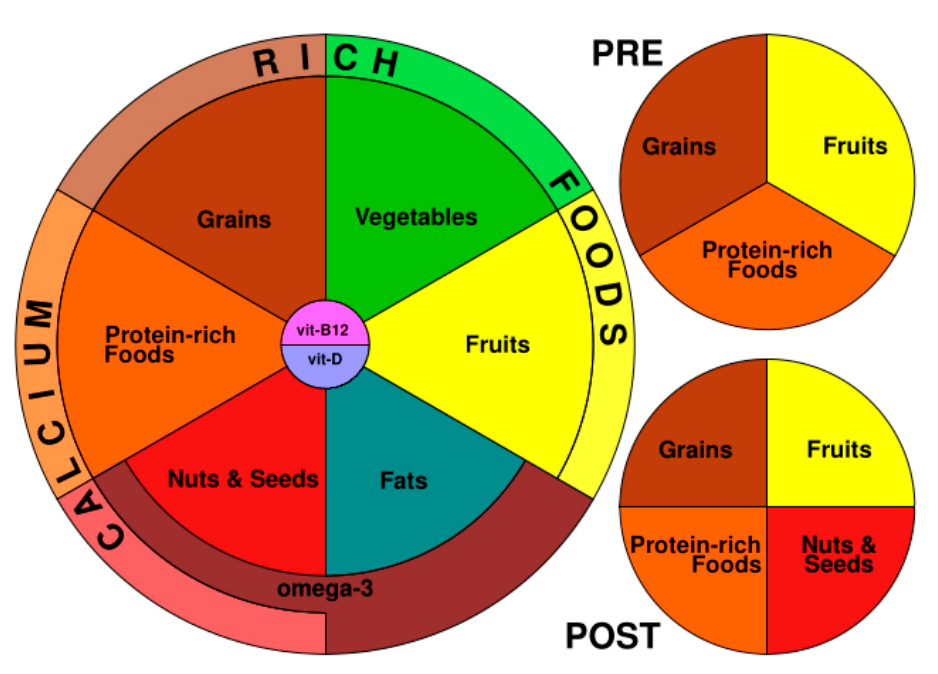
Figure 1. The VegPlate for Sports.